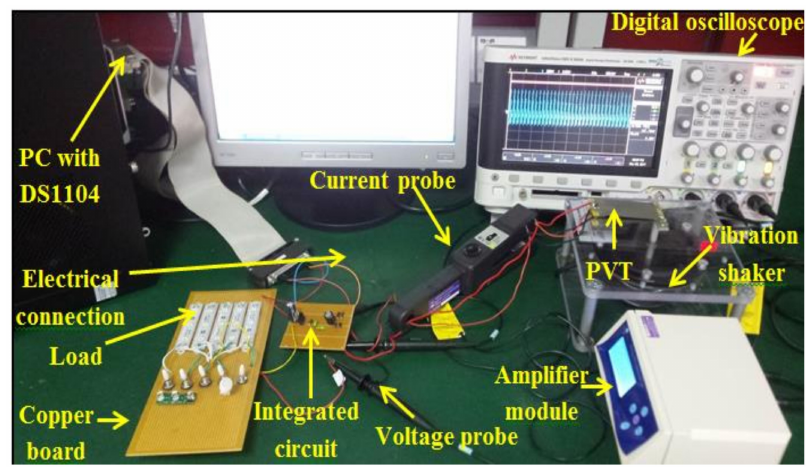
Figure 10. PEHS converter control process hardware setup with dSPACE.